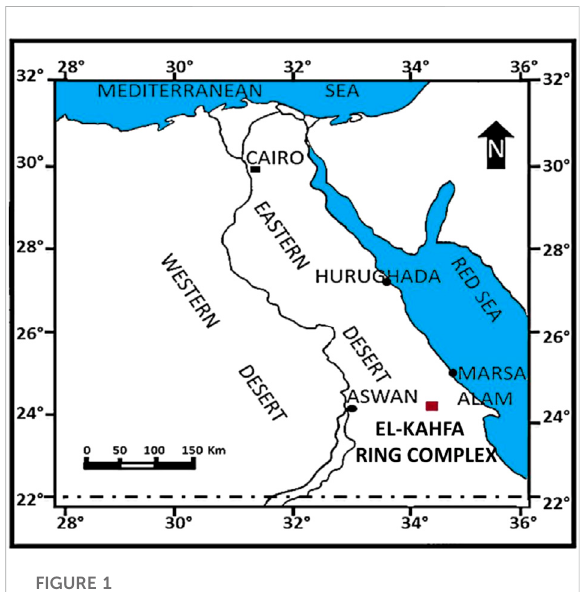
FIGURE 1 Map of the location of the Gabal El Kahfa ring